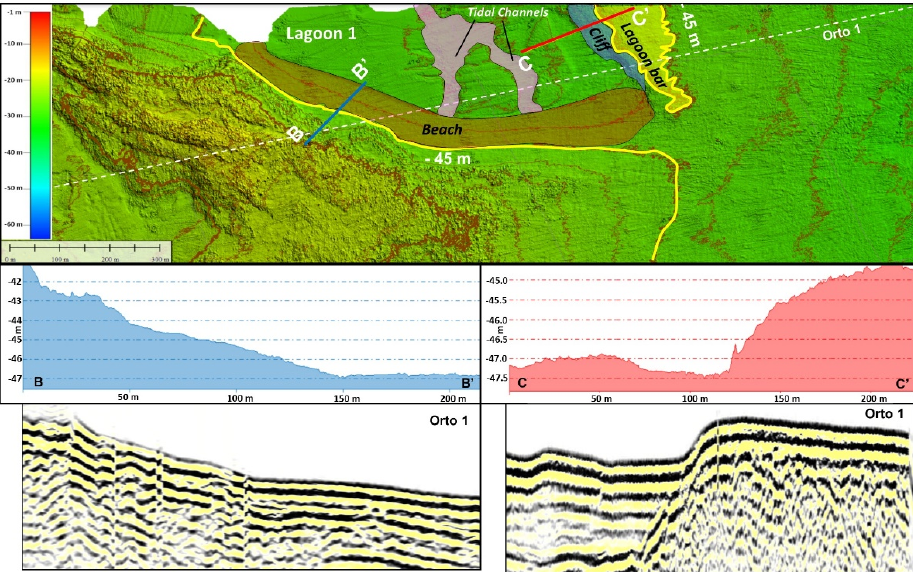
Figure 7. Location of Lagoon 1 within the northern sector of the study area and the comparison between the bathymetric profiles to the west (B–B ′ ) and to the east (C–C ′ ) of L1 and the seismic between the bathymetric profiles to the west (B–B (cid:48) ) and to the east (C–C (cid:48) ) of L1 and the seismic Geosciences 2021 , 11 , x FOR PEER REVIEW profile (Orto 1). profile (Orto 1).